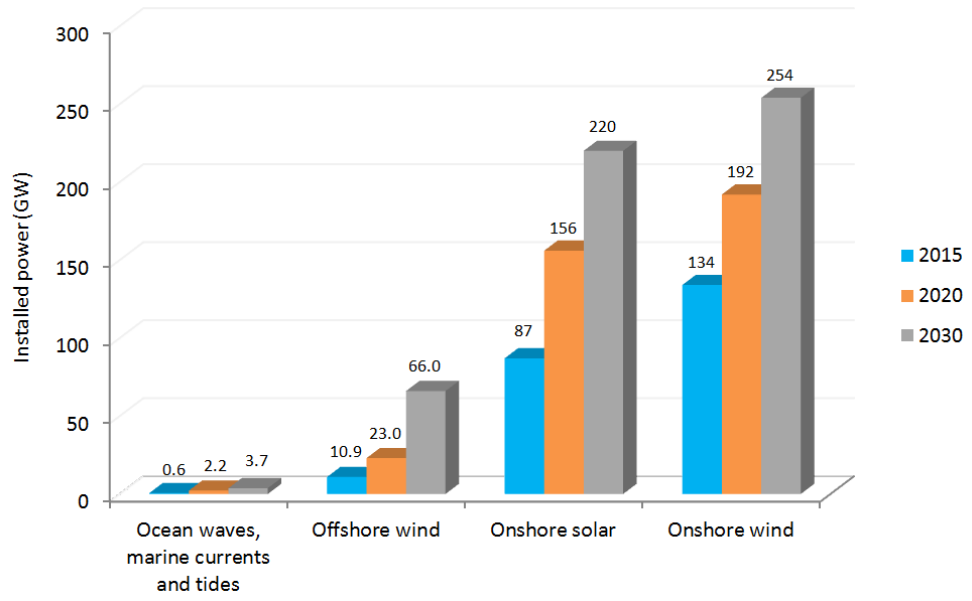
Figure 9. Global view of onshore and offshore renewable facilities in Europe: installed power, in GW, in 2015, and forecasts for 2020 and 2030.